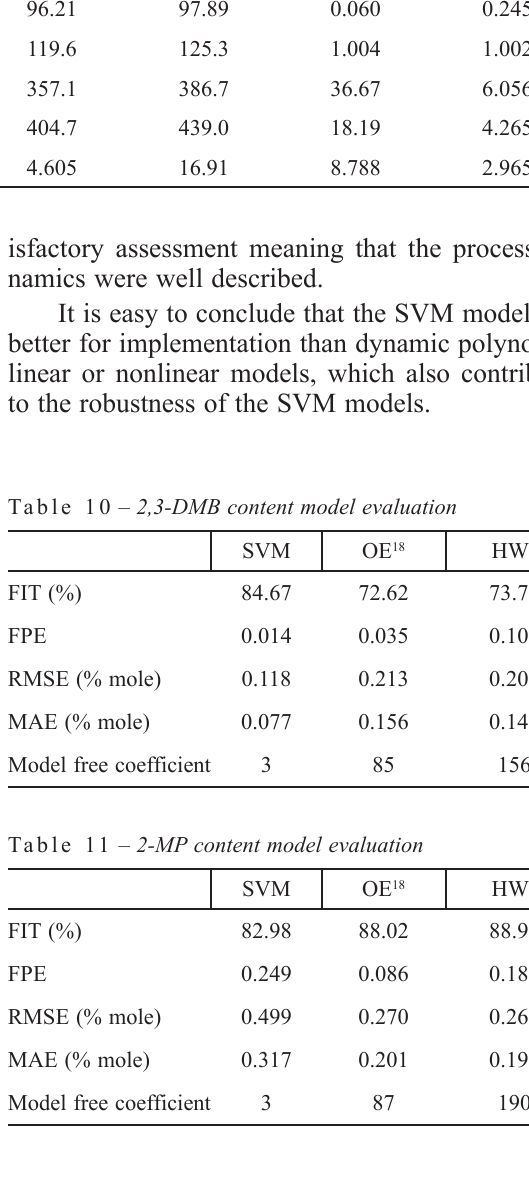
Variable Samples